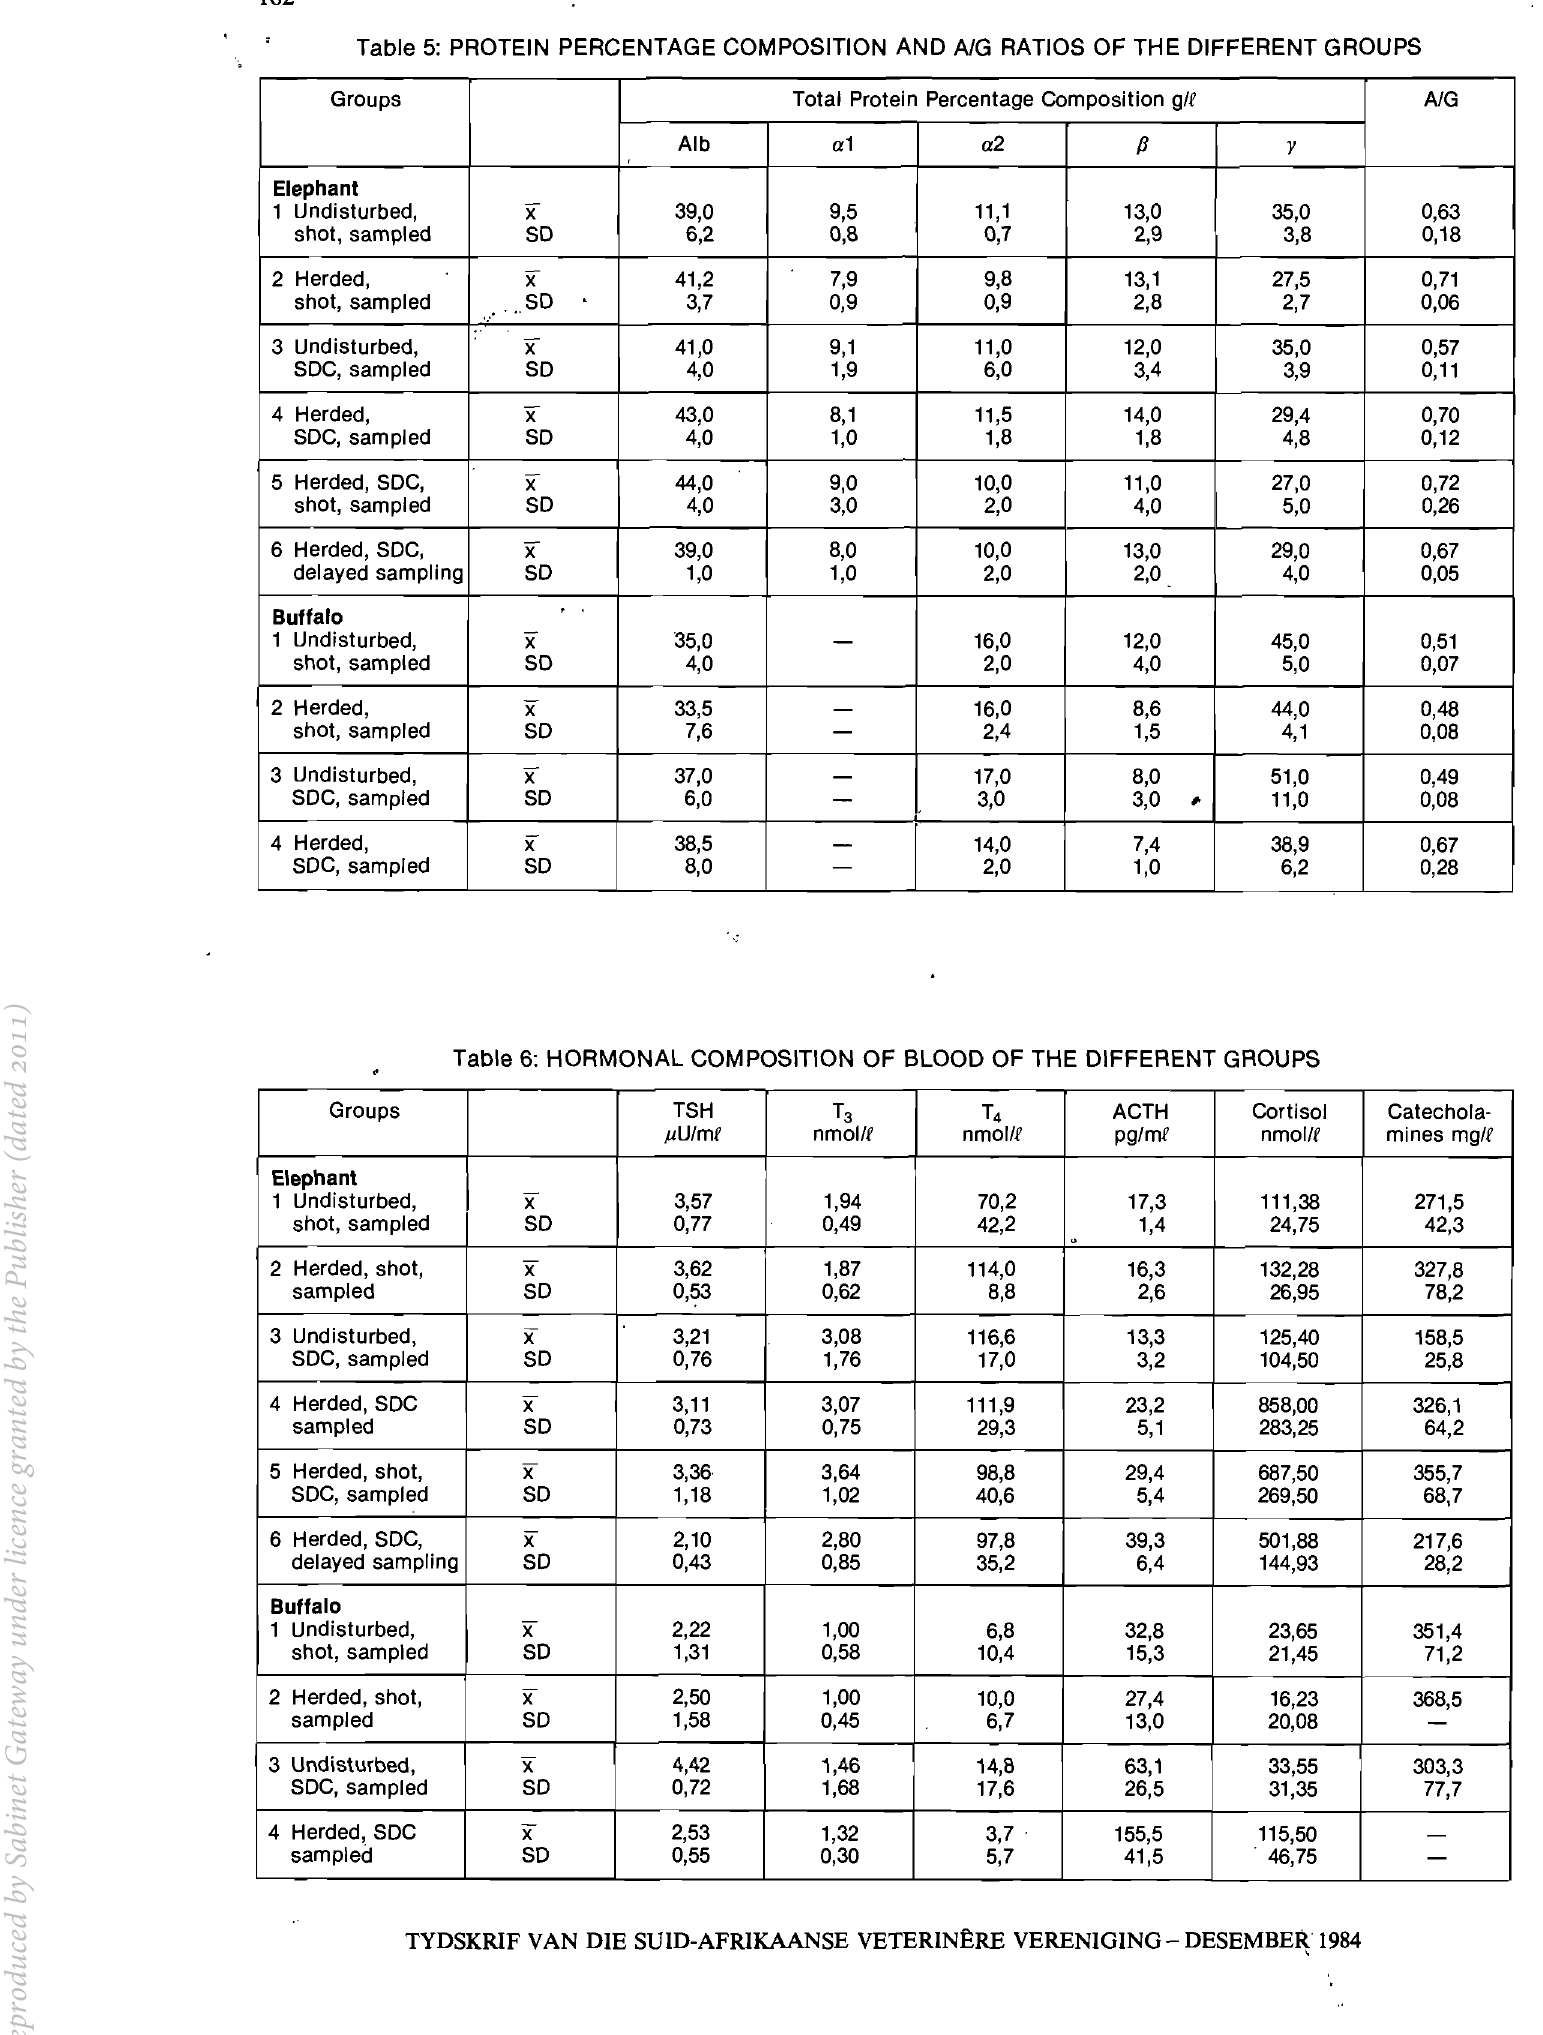
Table 6: HORMONAL COMPOSITION OF BLOOD OF THE DIFFERENT